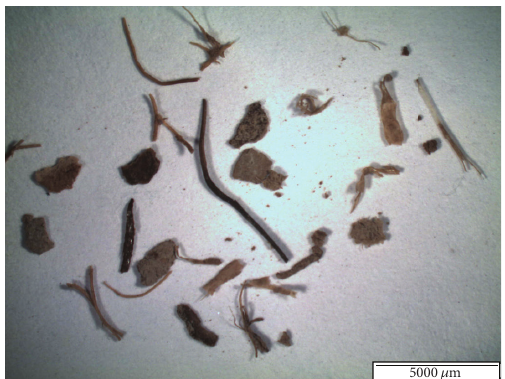
F 8: �ifferent shapes and lengths of non-oily POME �bres.